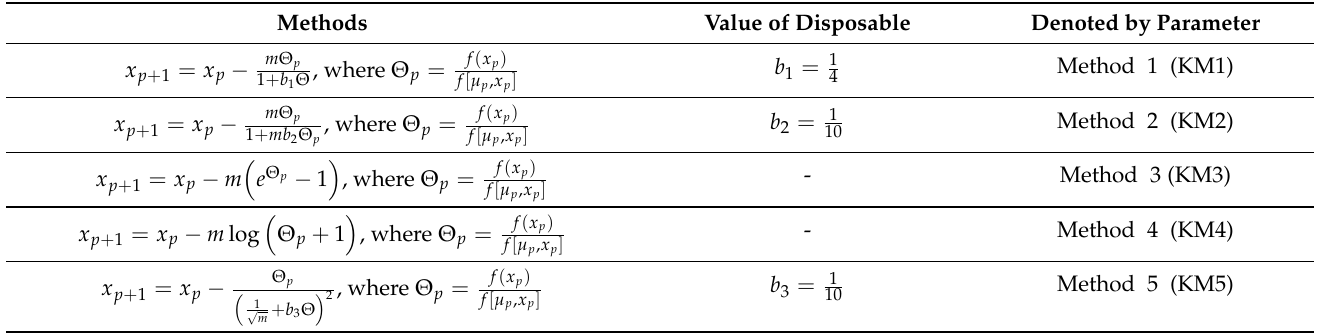
Table 2. Different methods of Kumar et al. [11]